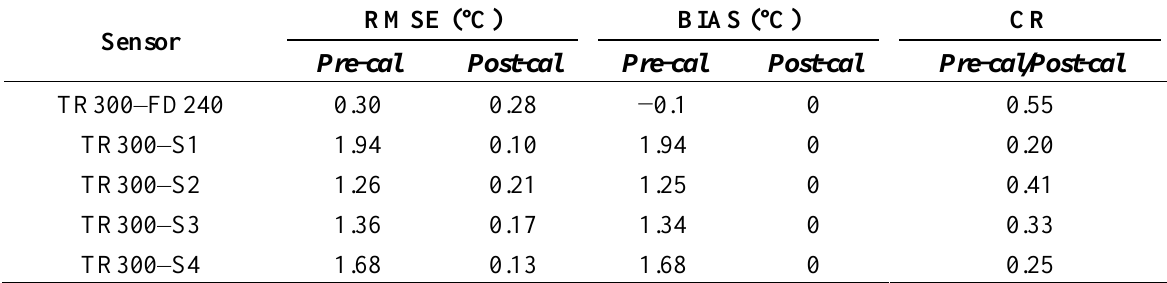
Table 2. Outcome parameters for temperature measurements. CR is not affected by bias compensation, by definition. Sensors 1 and 4 are the best, Sensor 2 the worst. All measurements in